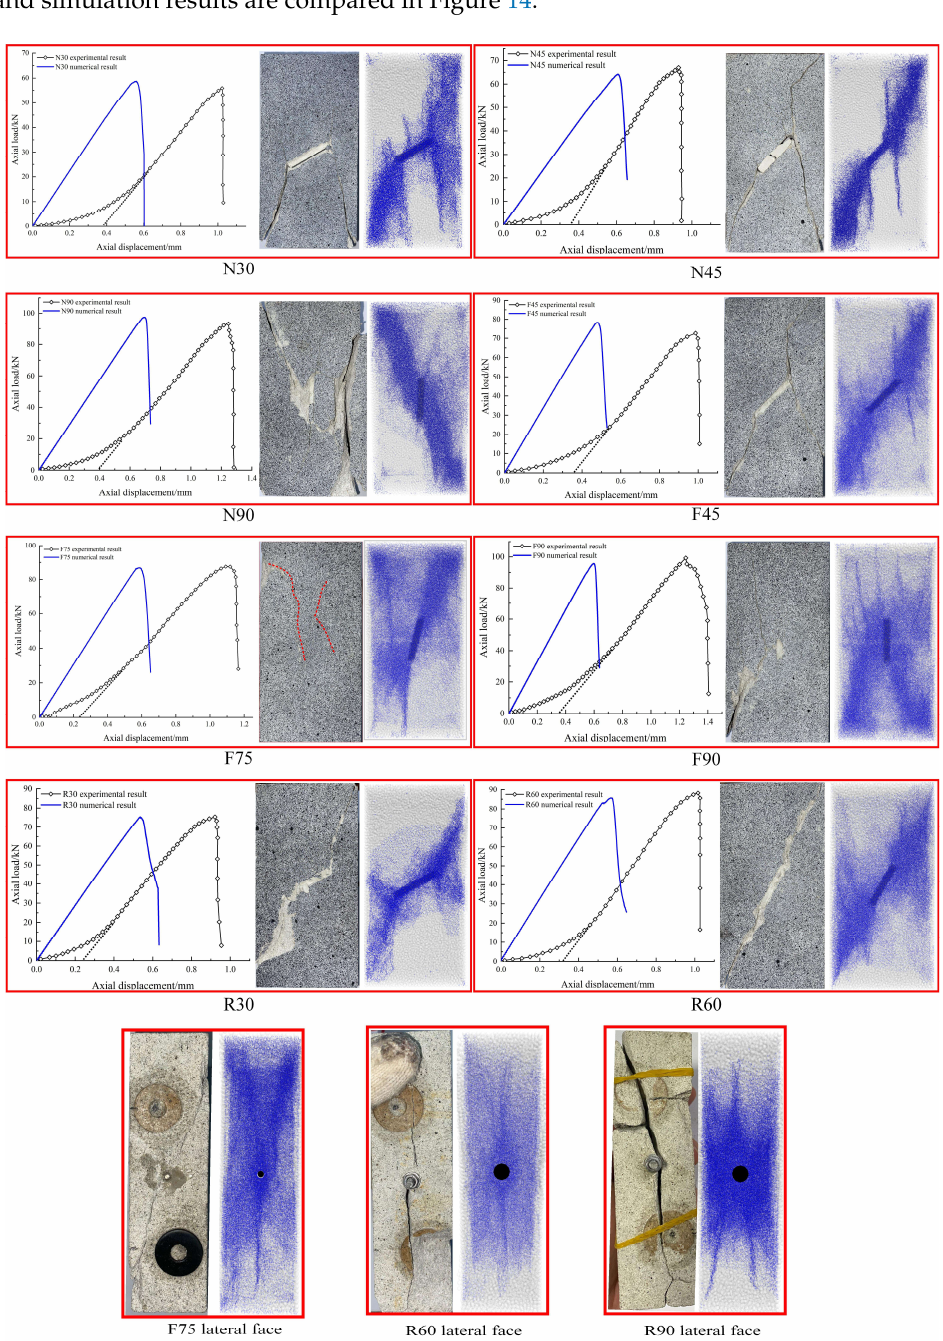
Figure 14. Comparison of some typical test results and numerical simulation results. Some samples with typical failure characteristics were selected for comparison. There were no micro-fissure closure stages in the force–displacement curves in the simulation results. When establishing the model, suspended particles often exist, as seen in Figure 15a. Suspended particles may lead to a large and unbalanced force in the initial model. At the same time, the suspended particles contact the surrounding particles in the compres- sion process, resulting in an increase in modulus and strength. In fact, this increase is more in line with the compaction process in real rock compression. However, the increase in modulus and strength in the compression process is uncontrollable, and its specific value cannot be calculated. Therefore, it is impossible to determine the elastic modulus value of